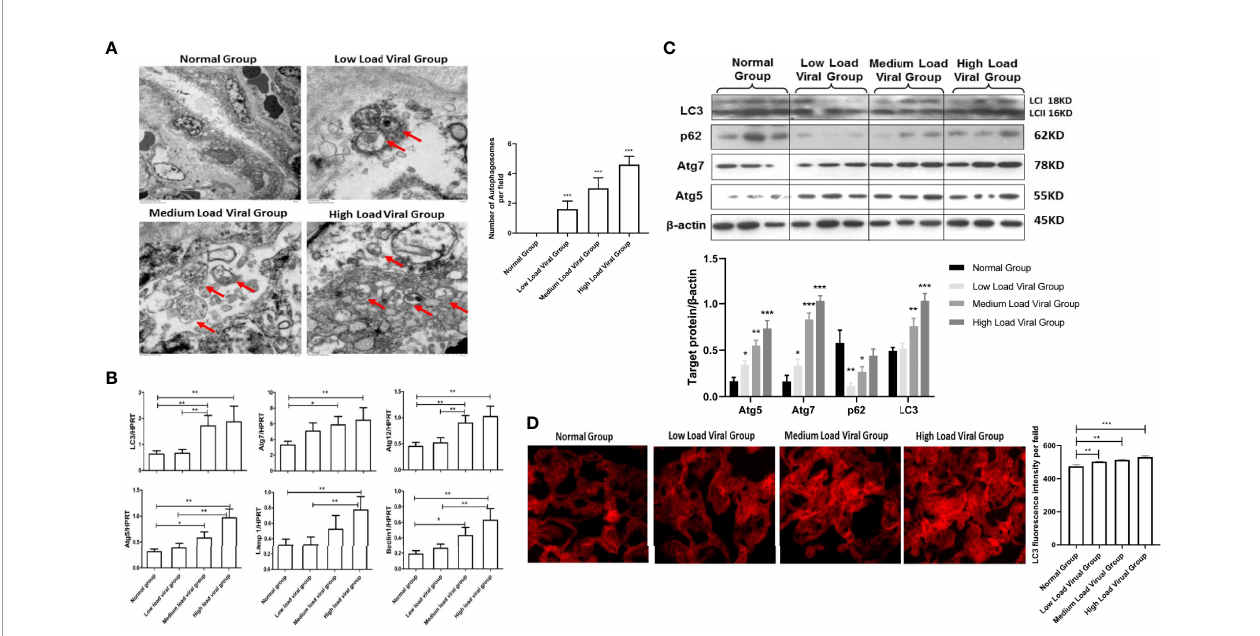
FIGURE 2 | Expression differences in autophagy markers in the placenta of pregnant women with different HBV loads. (***p<0.001, **p<0.01, *p<0.05). (A) The number of autophagosomes was detected by electron microscopy, the autophagosomes were indicated by red arrows and quanti fi ed by randomly selecting and screening 100 fi elds for two samples in the normal group, low viral load group, medium viral load group, and high viral load group, respectively. The representative images from each group are shown. (B) mRNA expression of LC3, ATG7, ATG12, ATG5, Lamp1, Beclin-1 was measured by qPCR among low viral load group (35 cases), medium viral load group (34 cases), high viral load group (18 cases), and normal group (25 cases). Data are shown as mean ± SD of at least three independent experiments. (C) Protein expression of LC3, p62, ATG7, ATG5, and b -actin was measured by western blot among low viral load group (35 cases), medium viral load group (34 cases), high viral load group (18 cases), and normal group (25 cases). The results were repeated at least three times. The representative image from placental tissue of normal group and low, medium, high viral load groups are shown. (D) The protein levels of LC3 were measured with immuno fl uorescent assays in placental tissue of normal group, low, medium, high viral load groups (200×). The quantitative analysis of LC3 fl uorescence intensity per fi eld was examined by Image